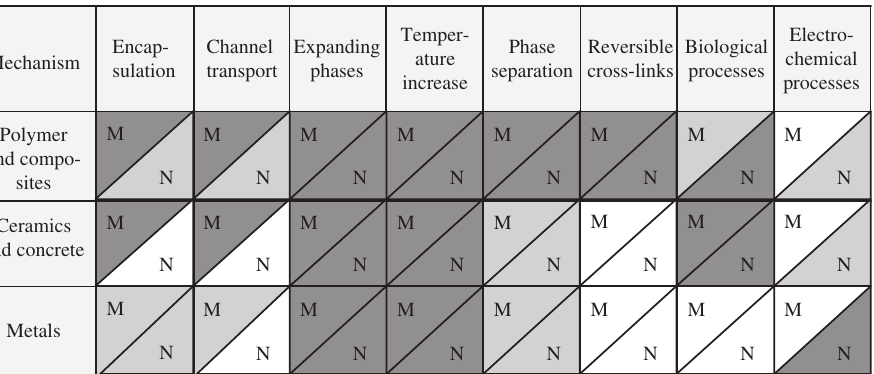
Table 1 Potential self-healing mechanisms for different material classes and examples.